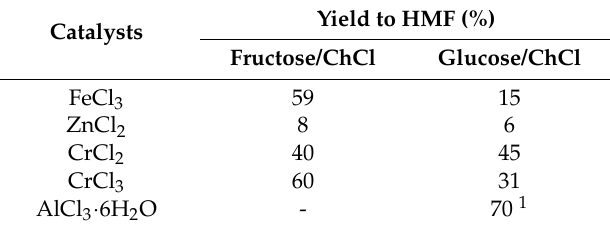
Table 1. Synthesis of HMF in the presence of different Lewis acids and choline chloride (ChCl)-derived LMMs [18,19]. Yield to HMF (%) Catalysts